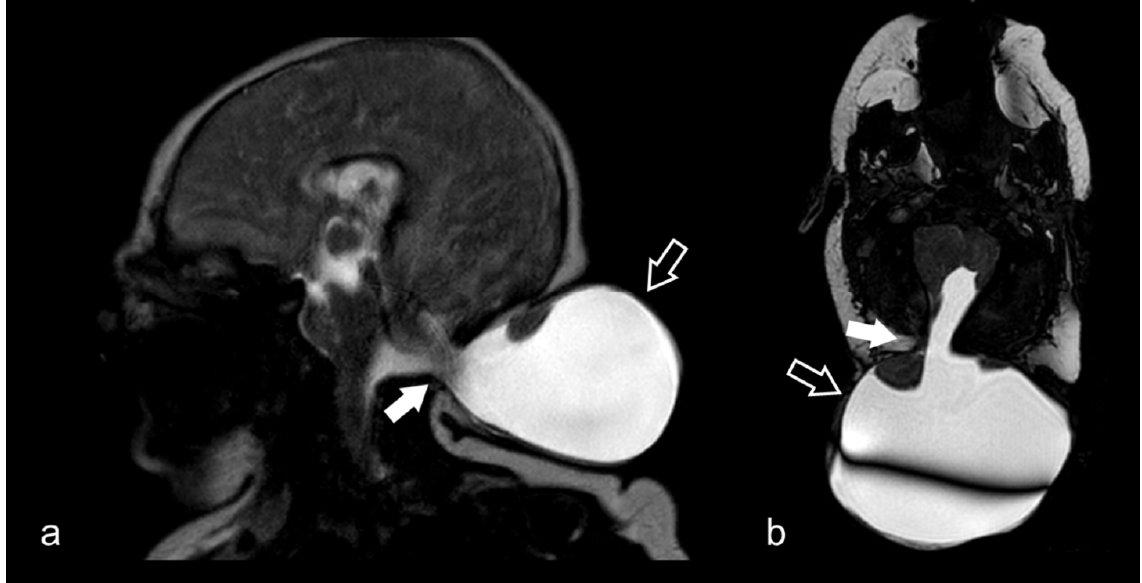
Figure 12. Sagittal ( a ) and axial CISS ( b ) images showing occipital meningoencephalocele (black arrows). Voluminous herniation of meningeal membranes, CSF and partially of brain tissue through a wide skull defect in the occipital bone (white arrows). Hypoplasia of cerebellum and dysmorphic brainstem can also be noted.